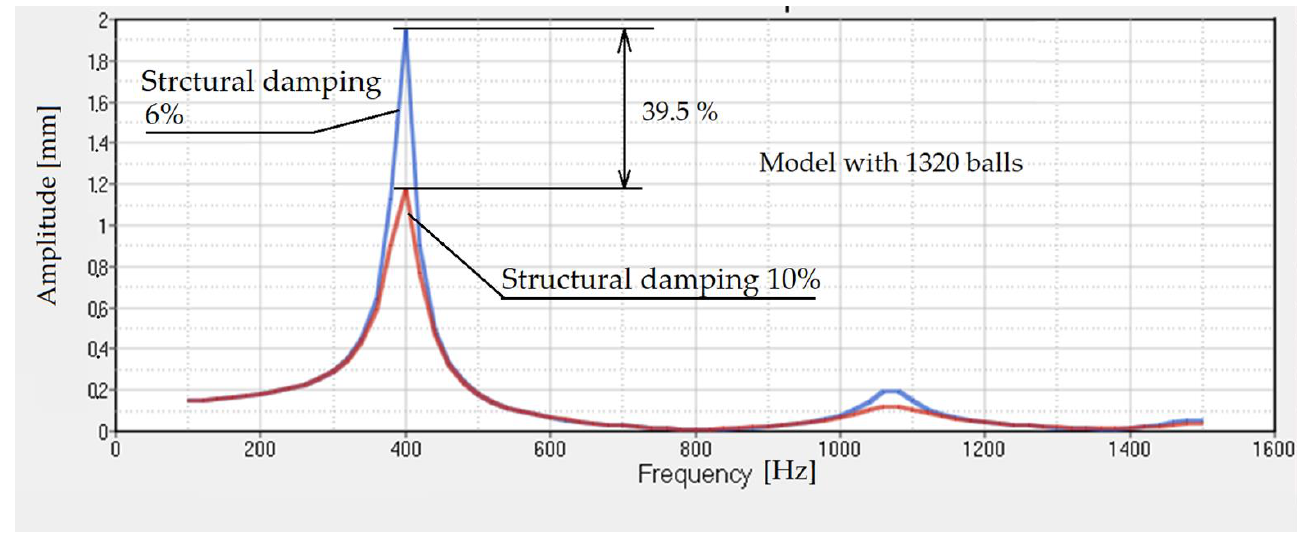
Figure 9. Transmissibility for: ( a ) rubber with voids; ( b ) rubber; and ( c ) rubber with steel balls. The structural damping is 6%.